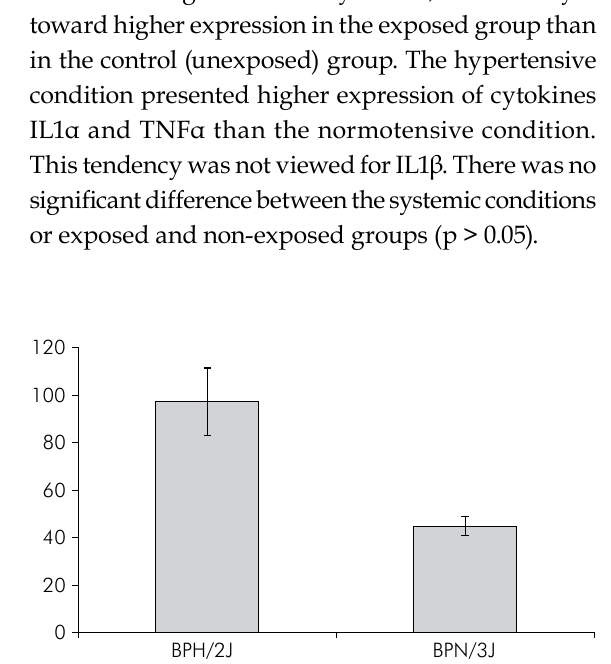
Figure 1. The value on x axis is the number of osteoclasts differentiated. n = 5 for each group. The difference is statistically significant between the hypertensive group (BPH/2J) and the normotensive group (BPN/3J).